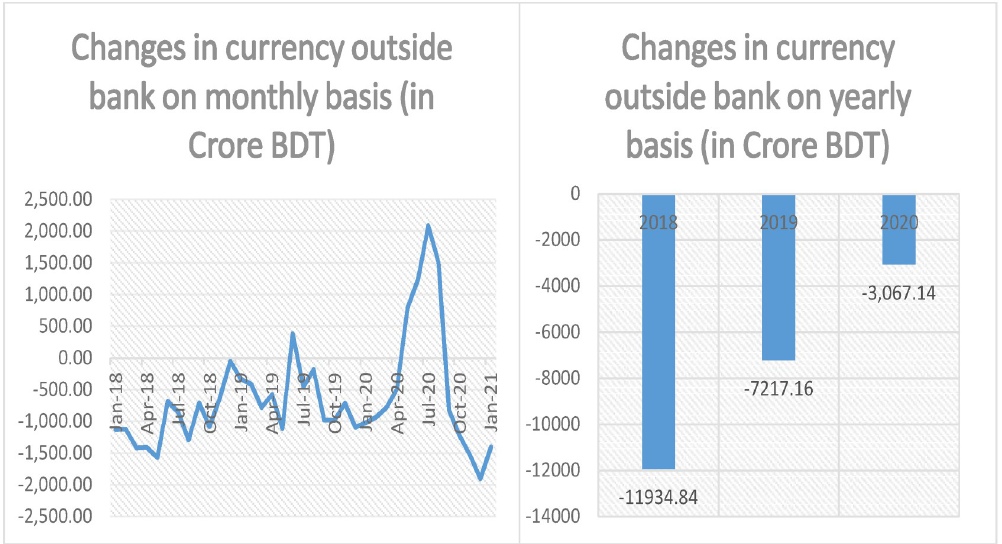
Fig 2. Monthly and yearly changes in currency outside bank due to MFS